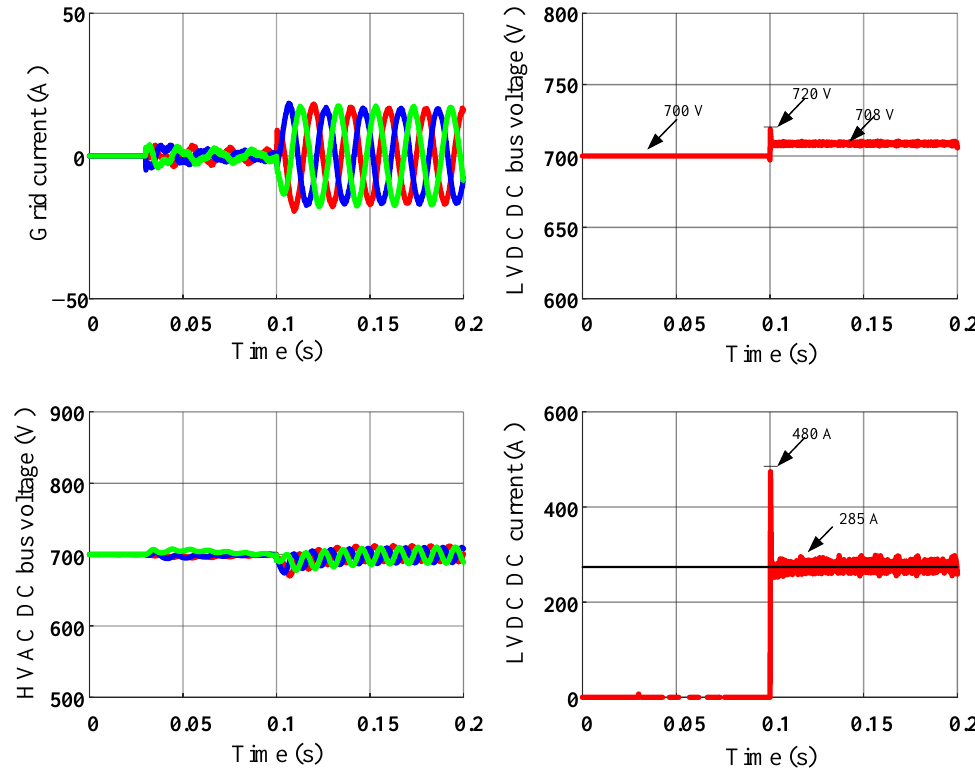
Figure 7. Simulation waveform (power from 0 step to 20% rated power).